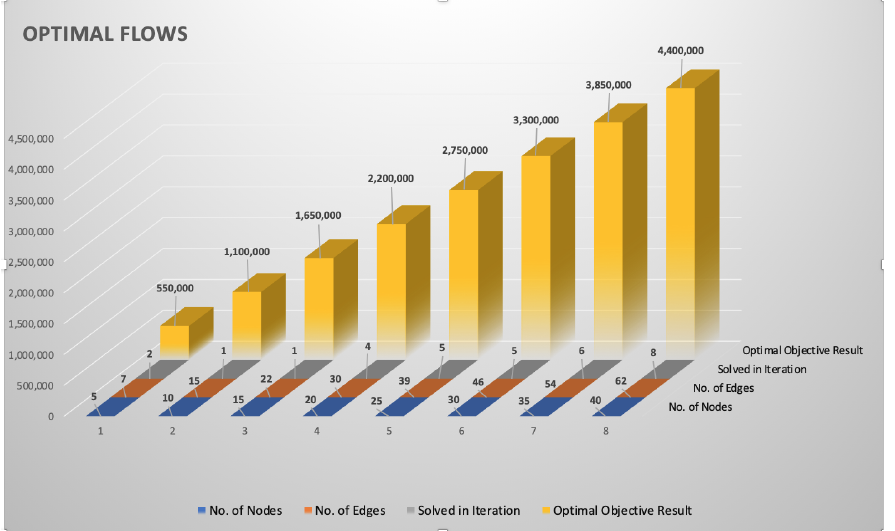
Figure 3. Optimal flows of packet